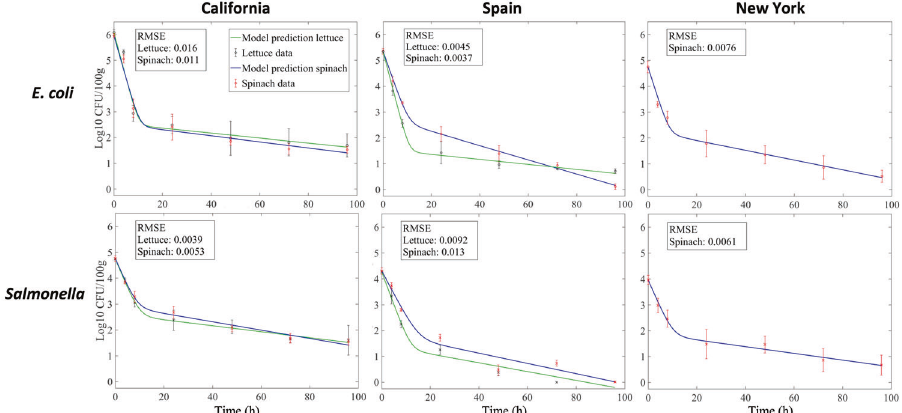
Fig. 2 Population size dynamics of E. coli (upper panel) and Salmonella (lower panel) in the lettuce and spinach phyllosphere in fi eld trials in California, Spain, and New York, and persister model fi ts for each crop (green line, lettuce; blue line, spinach). Sampling times were 0, 4, 8, 24, 48, 72, and 96 h post-inoculation. Each datum point represents the average population size and standard deviation from four subplots per trial from two, four, and one fi eld trial(s) in California, Spain, and New York, respectively, as detailed in Materials and Methods. For details regarding the frequency of samples above the limit of detection (6 CFU/100g) for the tail populations refer to the “ Details for parameter fi tting ” section in the appendix. The root mean square error (RMSE) from the optimal fi ts for population dynamics on each crop is provided as log10 CFU/100g in each fi